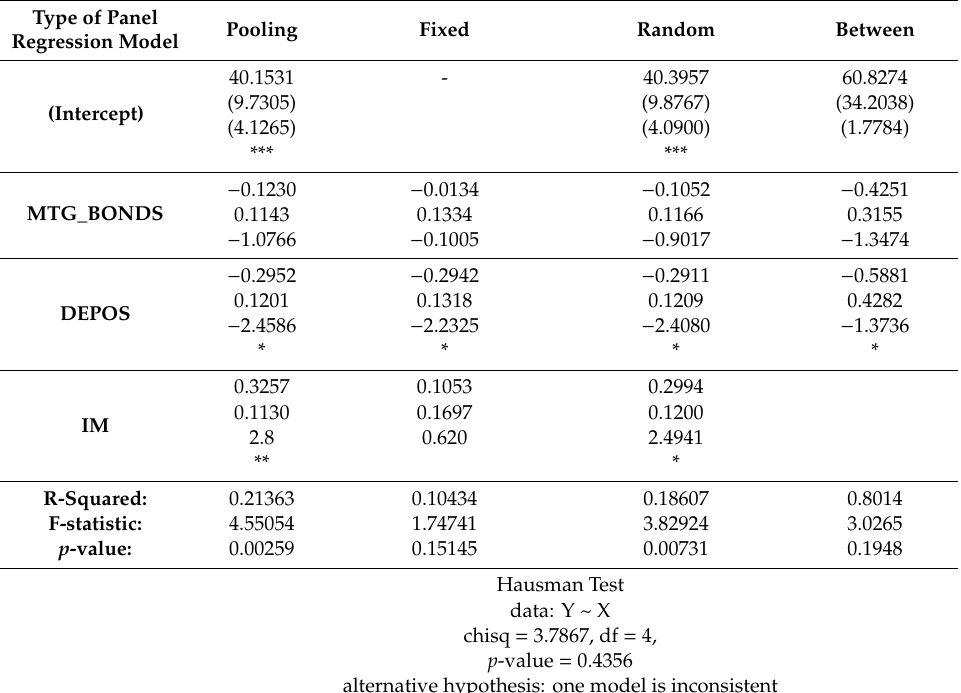
Table 5. HOUS_CRED ~ MTG_BONDS + DEPOS + PROFIT + IM. (Balanced Panel: n = 8, T = 9, N = 72). Type of Panel Regression